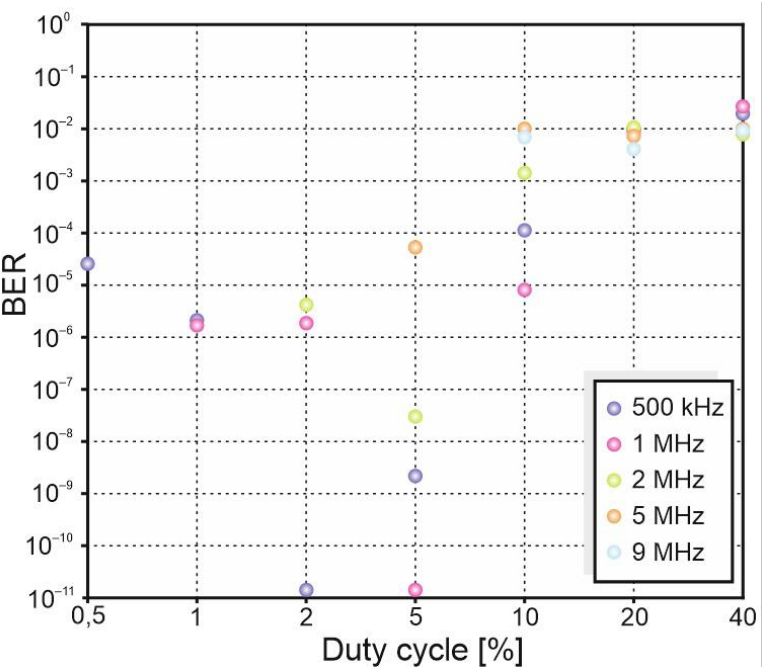
Figure 9. BER values for different pulse duty factors and frequencies at the laser operating temperature of 20 °C.